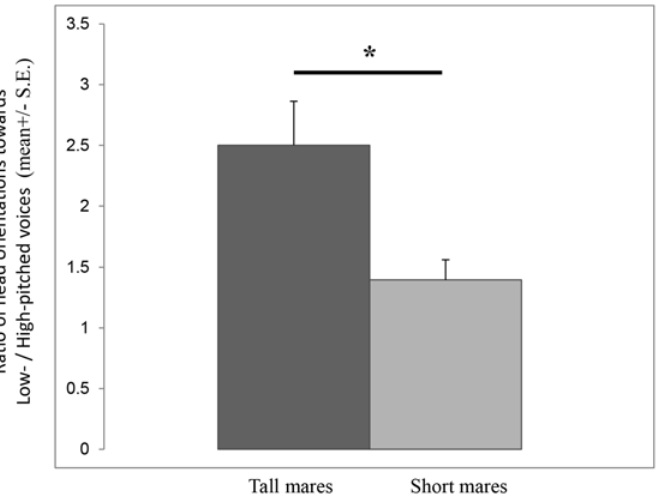
Fig 6. Group C mares ’ preference for low-pitched voices in relation with their size: tall (N = 7), short (N = 4). * Result of Mann-Whitney test: U = 3, P = 0.038.